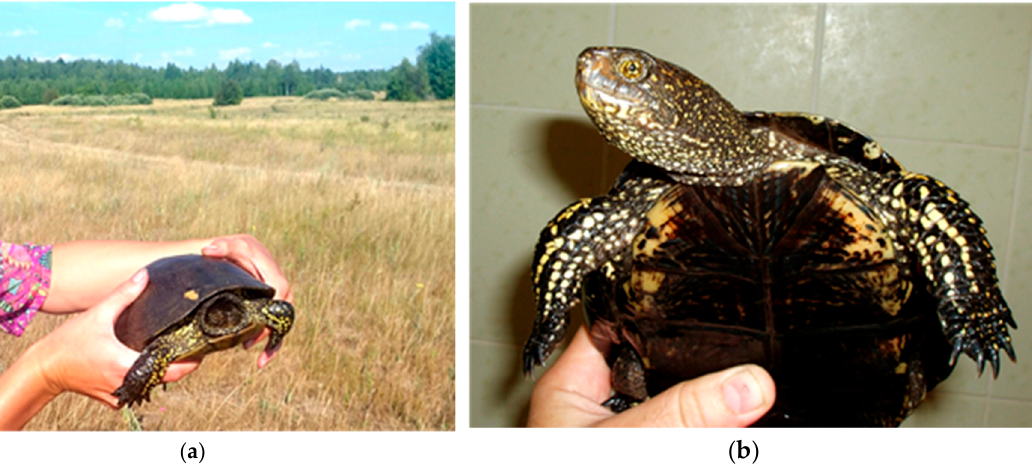
Figure 2. Fragments of the carapace ( a ) and plastron ( b ) of a pond turtle: ( a , top image) — with sign of kitchen knife cutting, ( a , lower image) — without a trace of cutting, for comparison, Neolithic, Cherkasskoe-3 (Voronezh region, Russian Federation, foto Ye. Yanish) and ( b ) — Antiquity, Olbia (Mykolaiv region, Ukraine, foto A. Buyskikh).